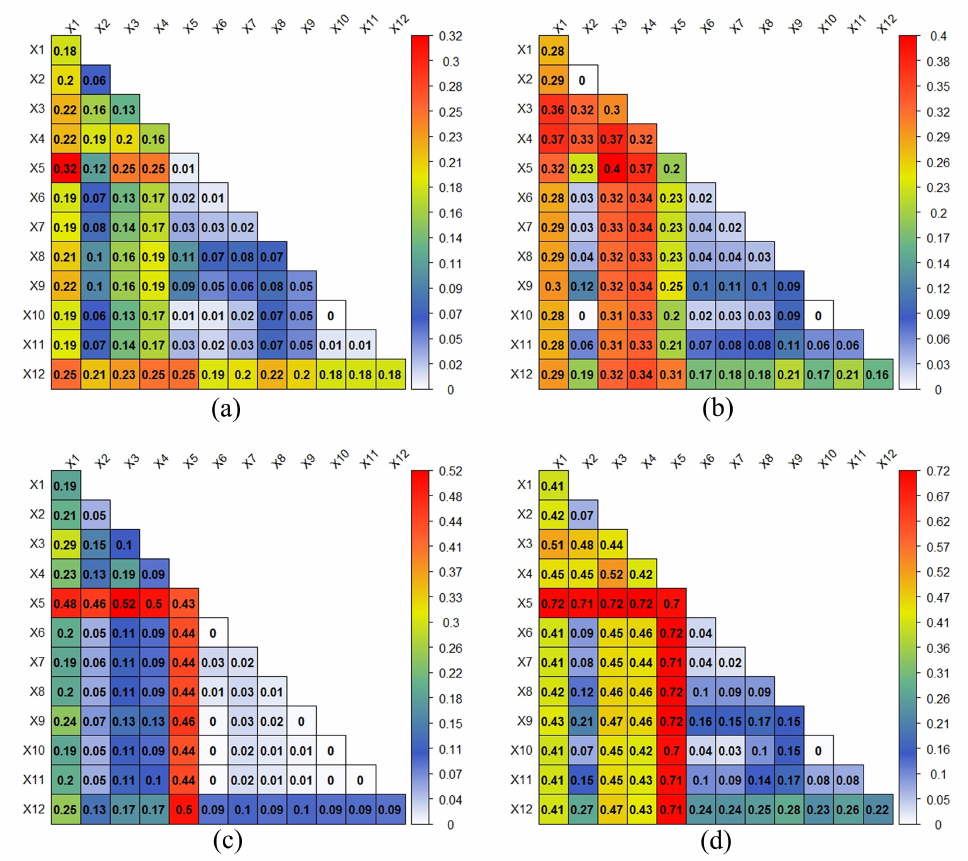
Figure 12. Interaction detector results of drought differences in the Yangtze River Basin. ( a ) 2000; ( b ) 2005; ( c ) 2010; and ( d )